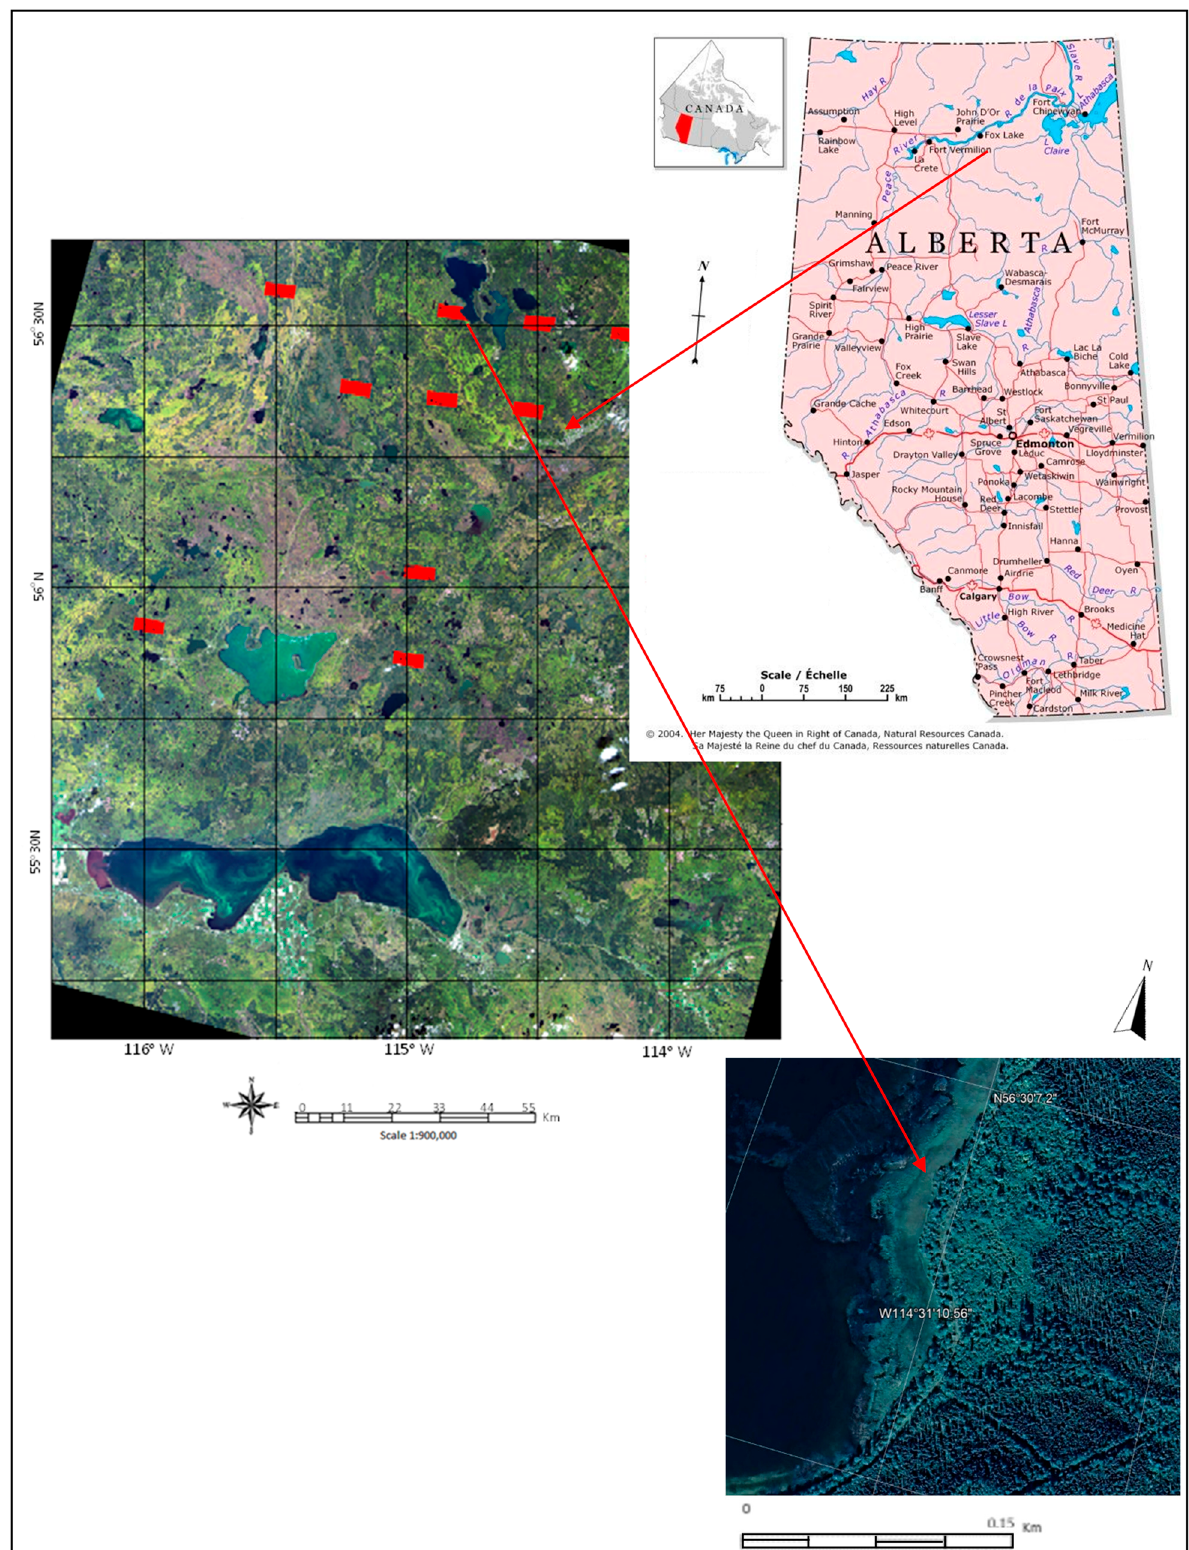
Figure 1. The study area from a geographic perspective together with a Landsat-8 True-Color image (RGB Bands 4, 3, 2) and aerial imagery. Individual study areas are highlighted as red polygons, drawn from the ABMI wetland inventory dataset on the Landsat-8 image.